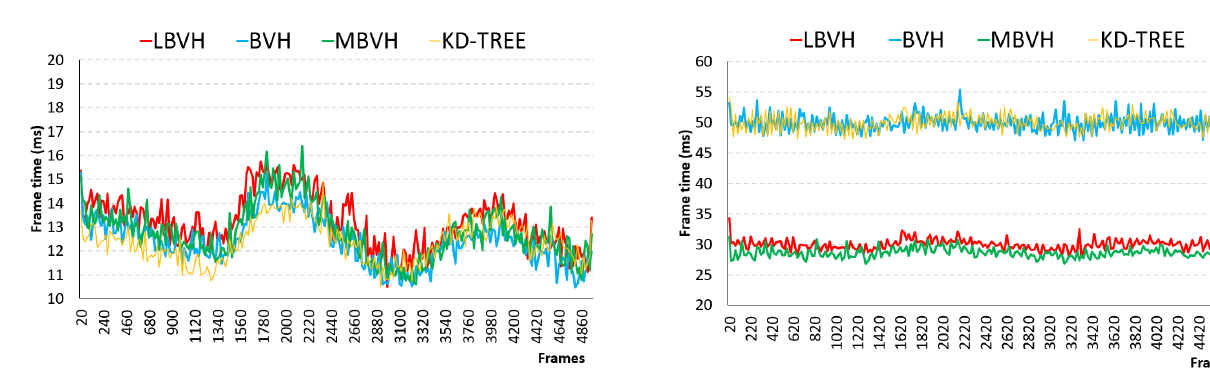
Fig. 9. Comparison of different acceleration data structures for reflections of a simplified geometric version of the static scene and two deformable T-Rex dinosaurs, in the walkthrough animation.